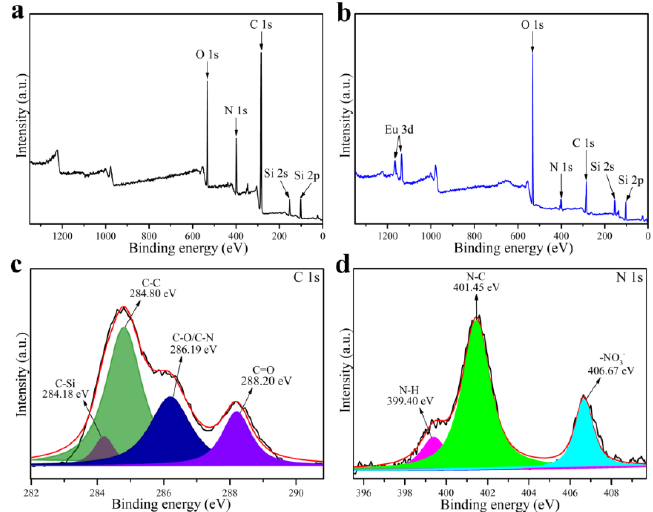
Figure 2. X-ray photoelectron spectra of SiCDs ( a ) and SiCDs@mMIP-cit-Eu probe ( b ). The detailed C 1s ( c ) and N 1s ( d ) spectra of SiCDs@mMIP-cit-Eu.